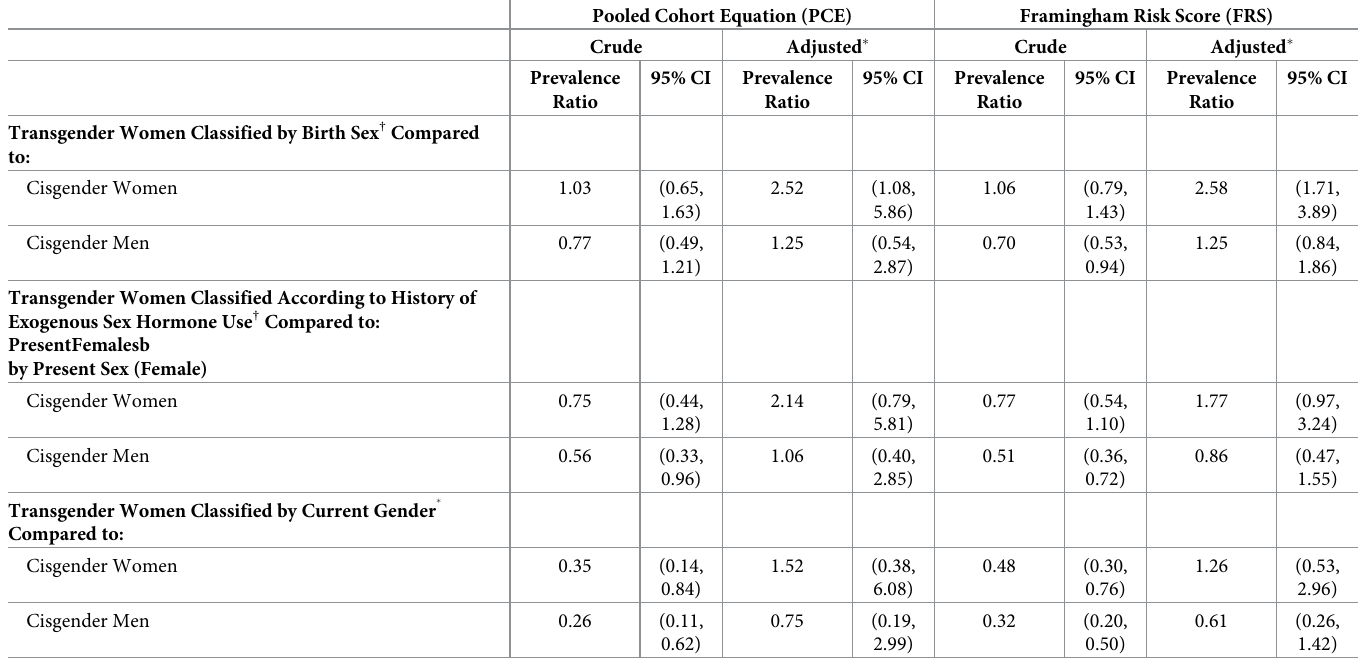
Table 3. Associations Between Sex and Gender and Elevated CVD Risk Scores Among 221 Transgender Women, 2,983 Cisgender Women, and 13,467 Cisgender Men Alive and Engaged in Continuity HIV Care in the CNICS, 2014–2018 (or contributing cohort-specific administrative censoring date) �